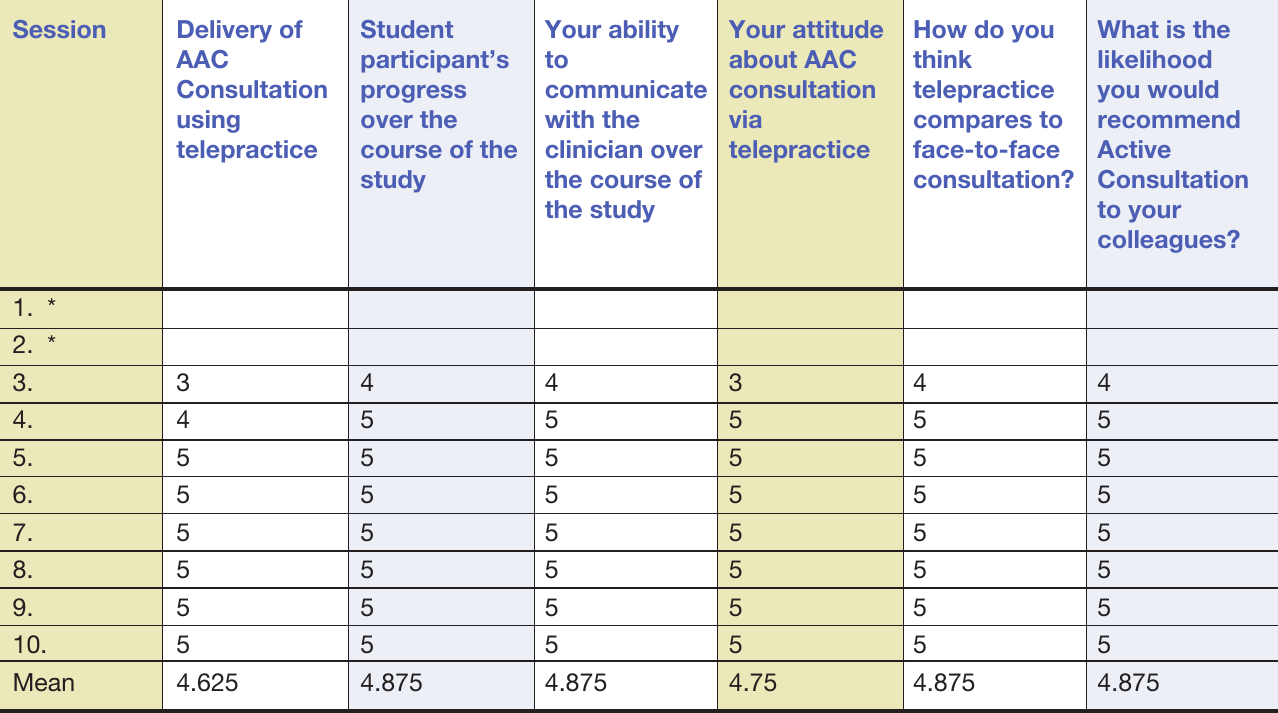
Table 5. Pre-professional Clinician Satisfaction Survey Responses